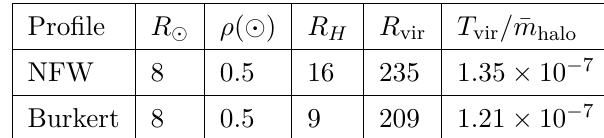
is the halo-averaged mass of a virialized halo